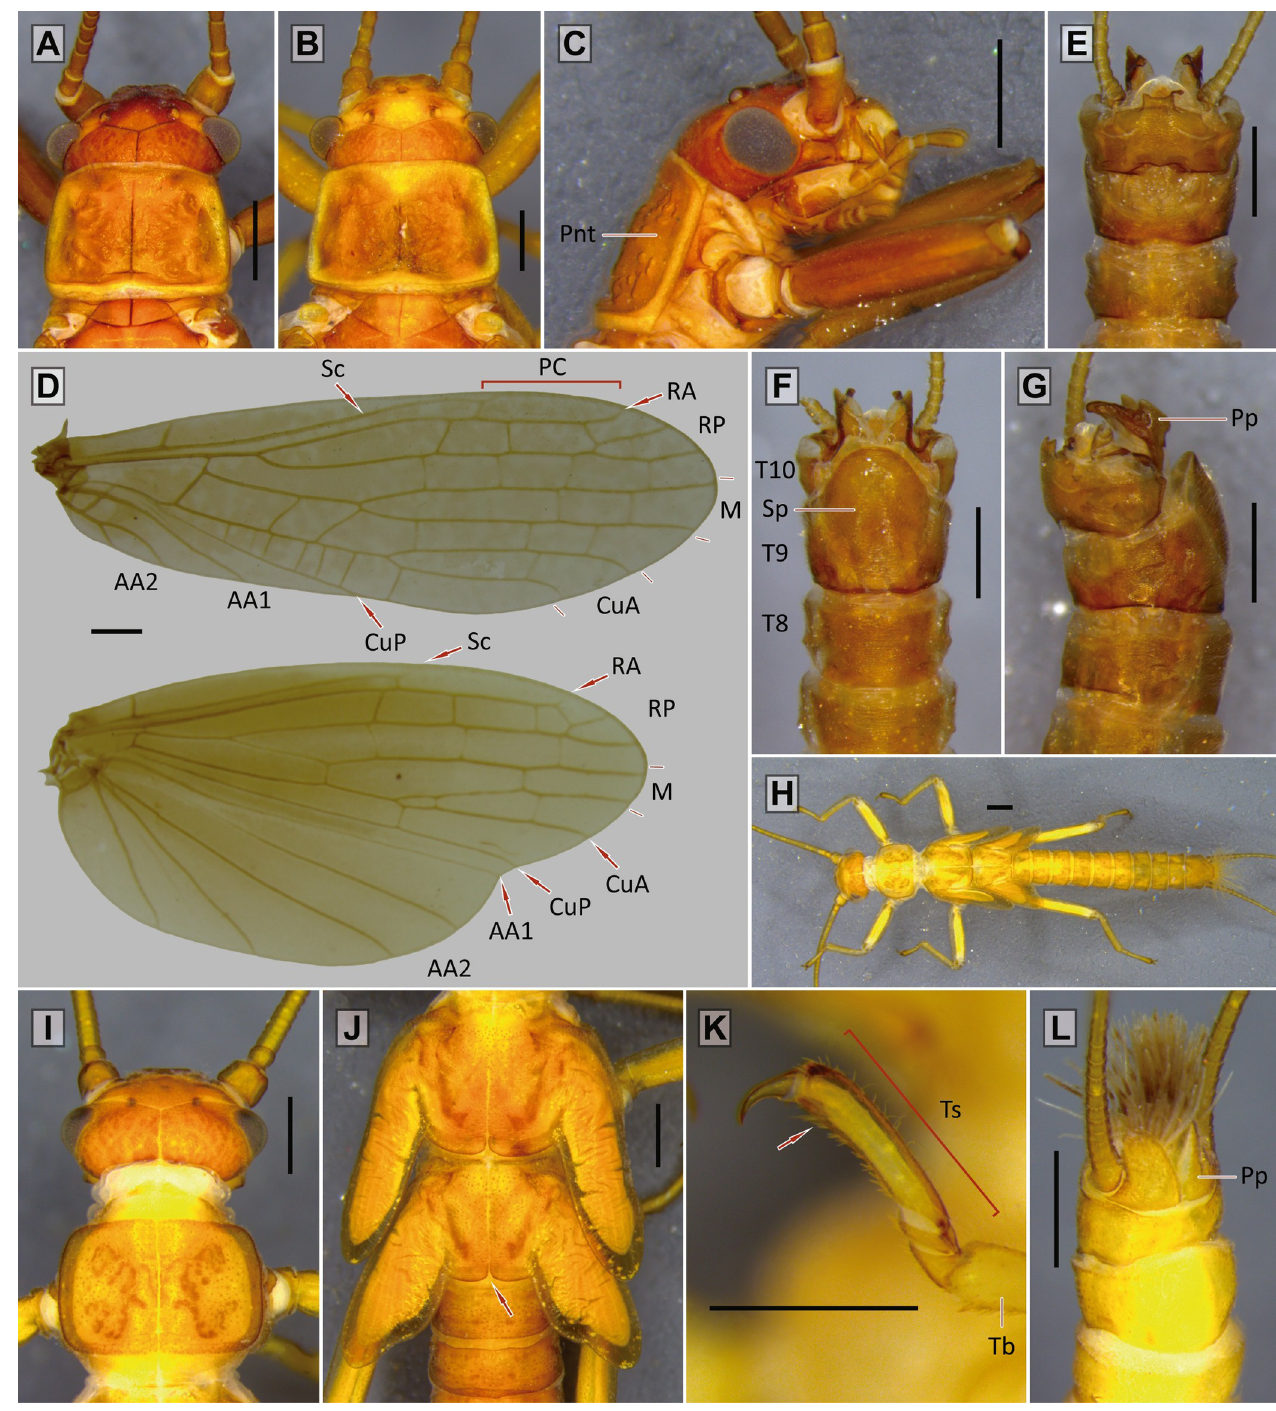
Fig 11. Paragripopteryx munoai Benedetto, 1969. (A) Paratype adult male, head and pronotum in dorsal view. (B) Paratype adult female, head and pronotum in dorsal view. (C) Adult male, head and pronotum in lateral view. (D) Male fore- and hind wings. (E , F , G) Male terminalia in dorsal, ventral, and lateral views, respectively. (H) Nymph, body in dorsal view. (I) Nymph, head and pronotum in dorsal view. (J) Nymph, meso- and metanotum in dorsal view. (K) Nymph, detail of tarsi. (L) Nymph, abdominal ends in latero-ventral view (Scale bars: A–L: 0.5 mm).